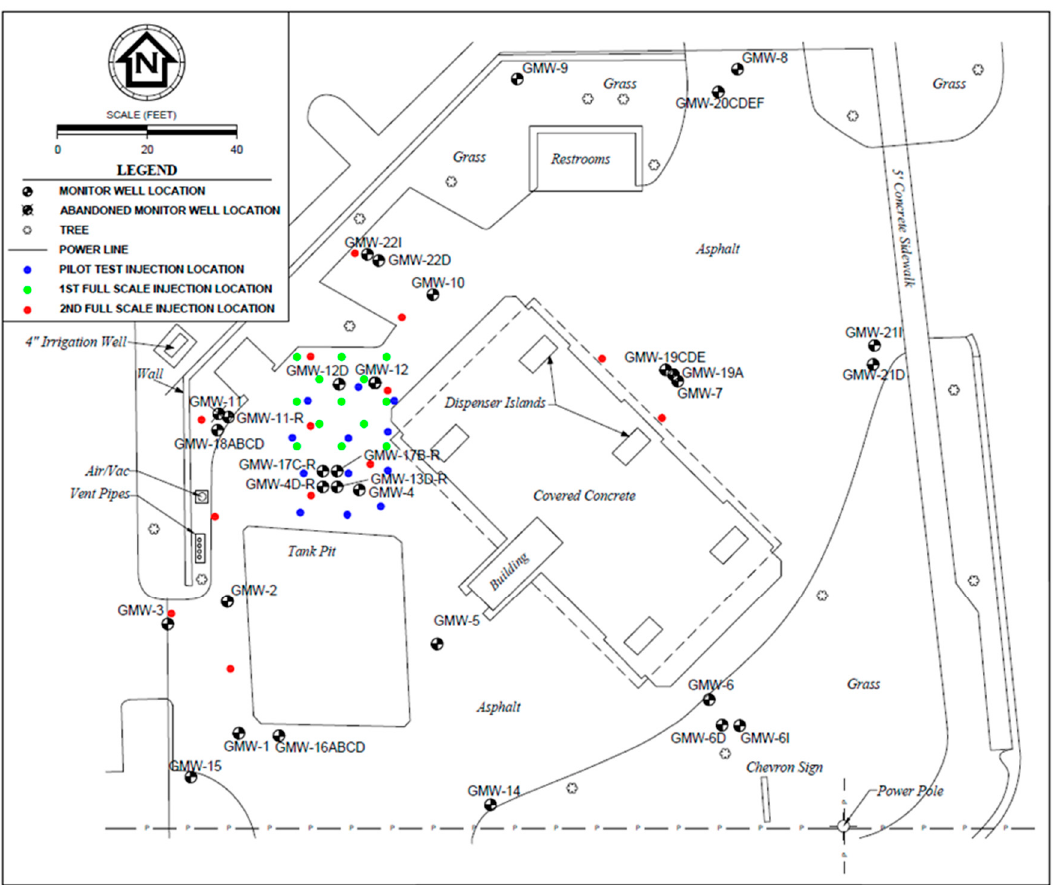
Figure 2. Case study general site plan with injection point locations.